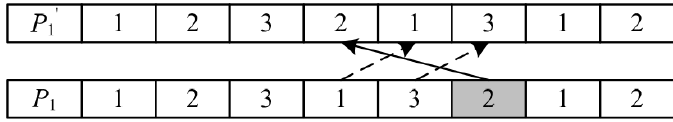
Figure 5. Mutation operation of processing sequence